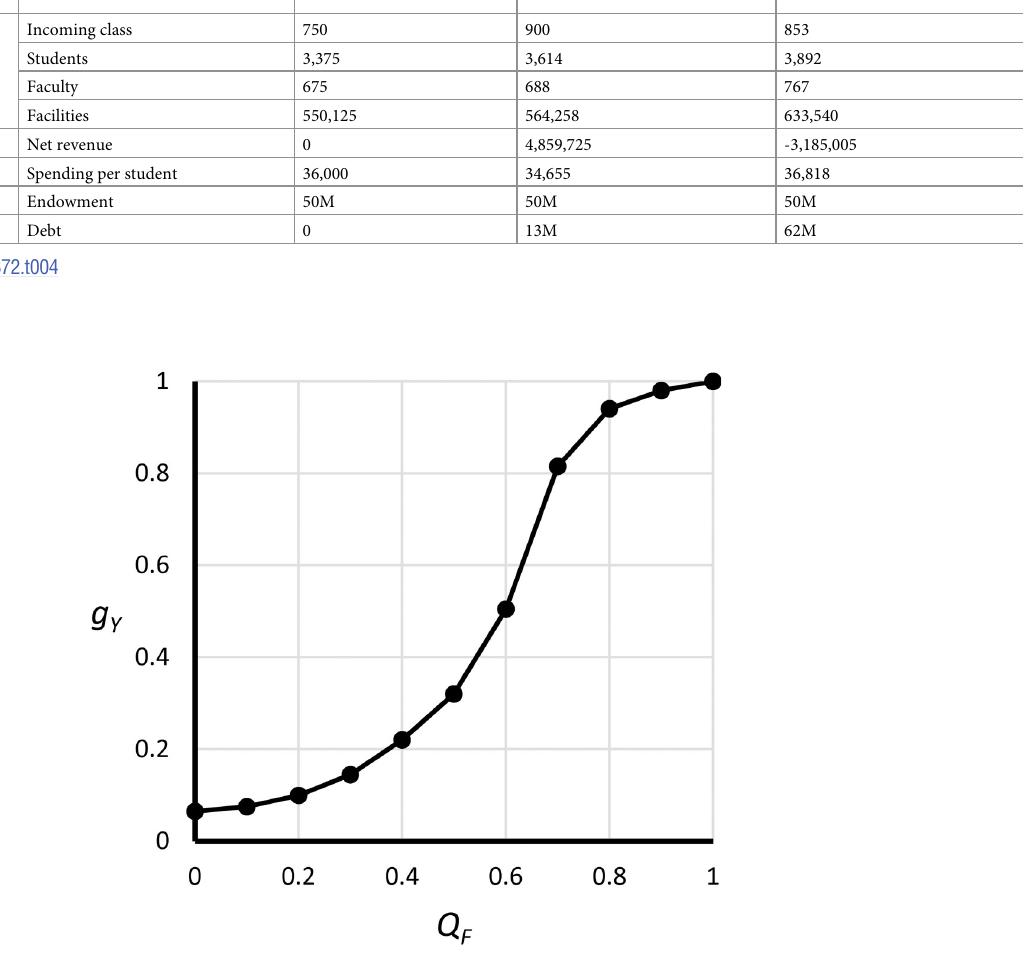
Fig 21. Graphical function g Y ( Q F